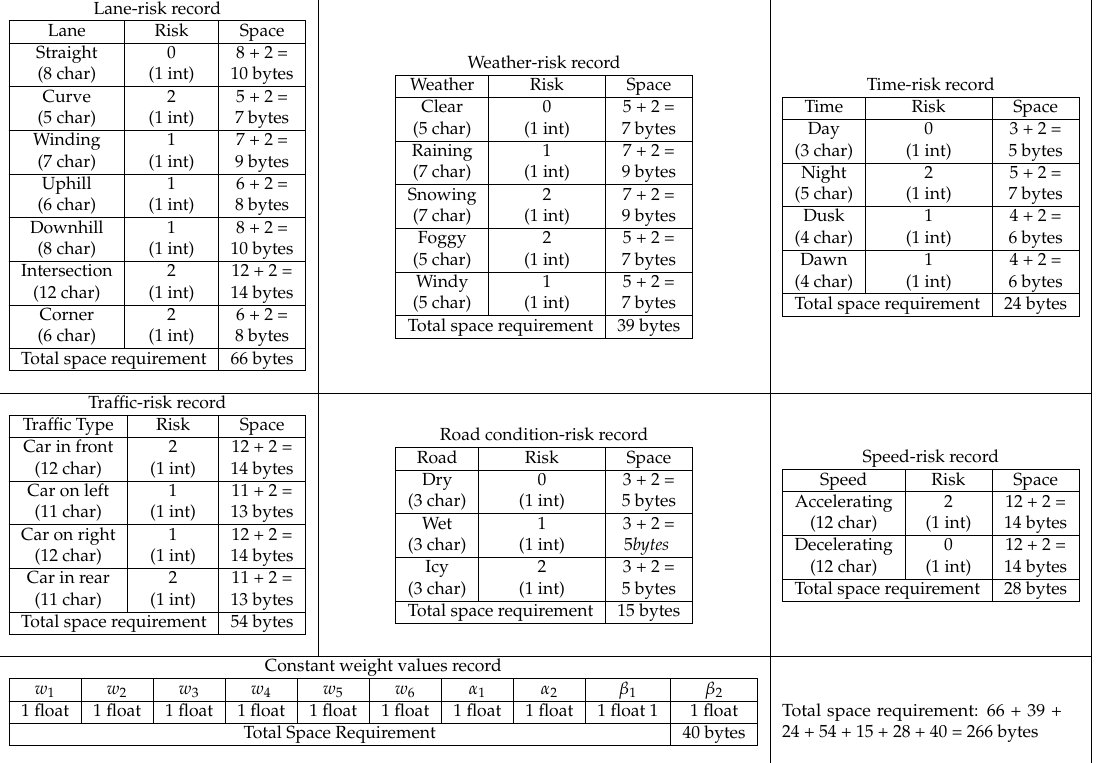
Table 9. Space requirement of existing